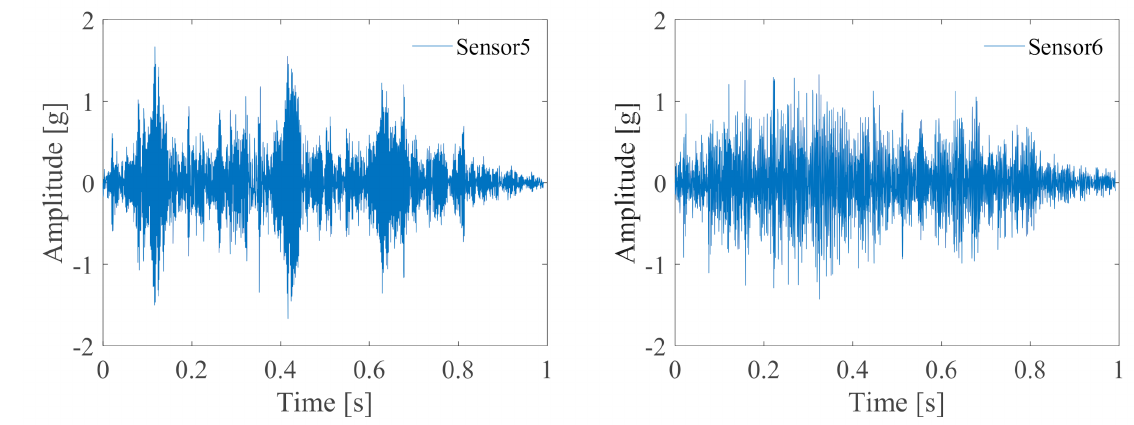
Figure 7. Processed signals in outer race fault experiment.